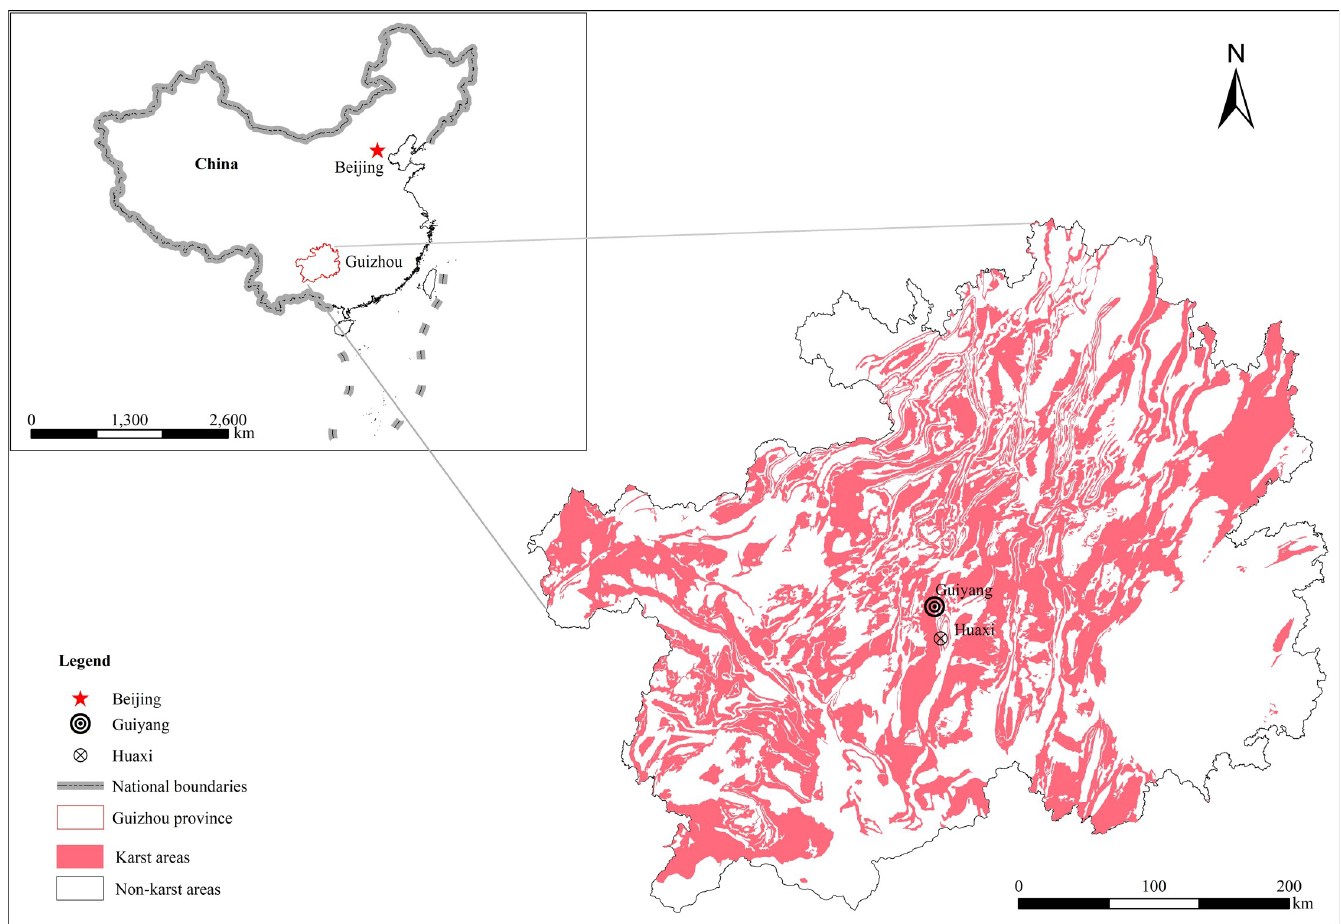
Fig 2. Location of the study area (Huaxi District, Guiyang city, Guizhou Province, China).